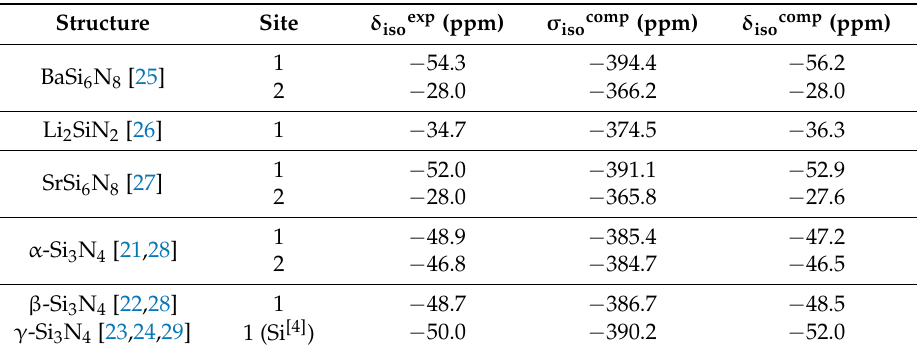
Table 1. Experimental 29 Si NMR chemical shifts, δ iso , computed absolute shifts, σ iso , and predicted δ iso of Si sites in a variety of crystalline silicon nitrides. The predicted value δ isocalc is based on a fit to the data; see Figure 1 and Equation